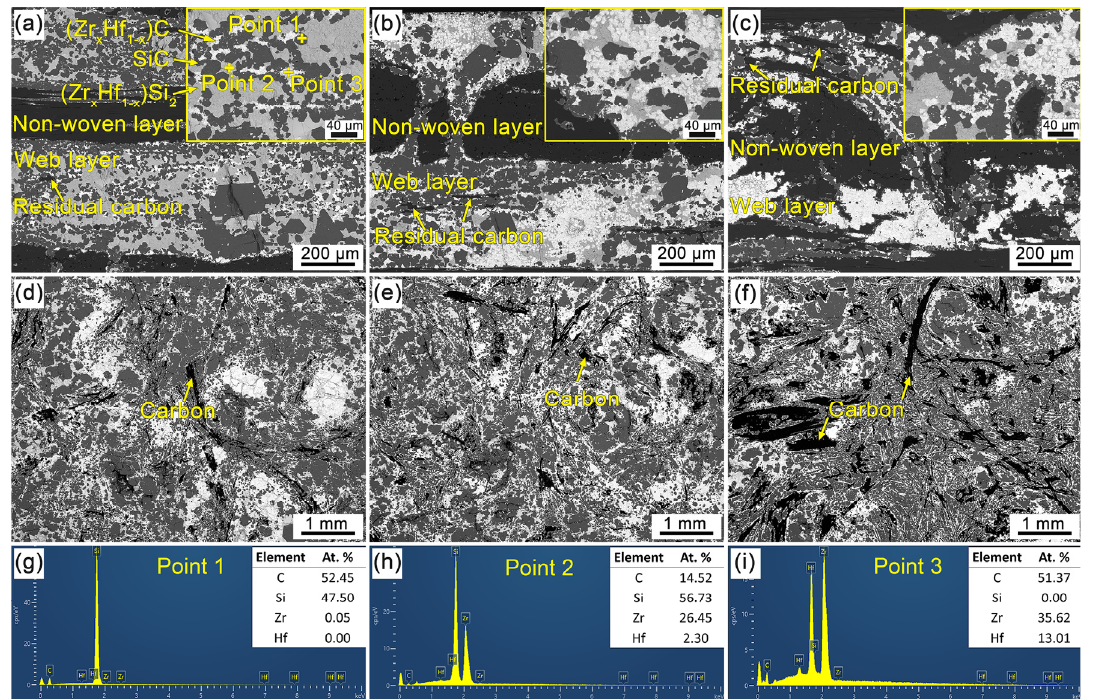
Figure 5. SEM micrographs and EDS results of the C/C-SiC-(Zr x Hf 1 − x )C composites: ( a , d ) CMC-1; ( b , e ) CMC-2; ( c , f ) CMC-3; ( g – i ) EDS results.